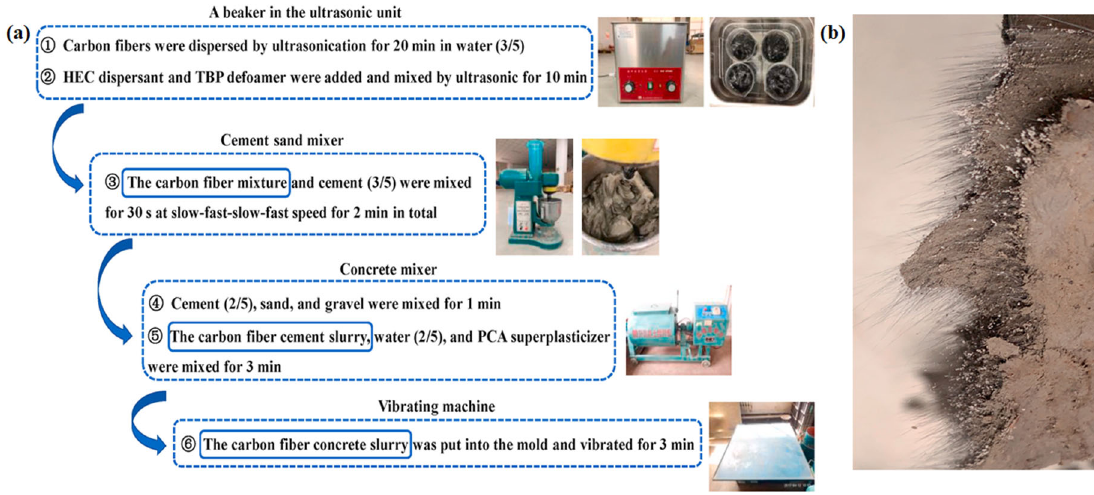
Figure 4. ( a ) Dispersion and mixing process of CFRC; ( b ) Fracture section [33].